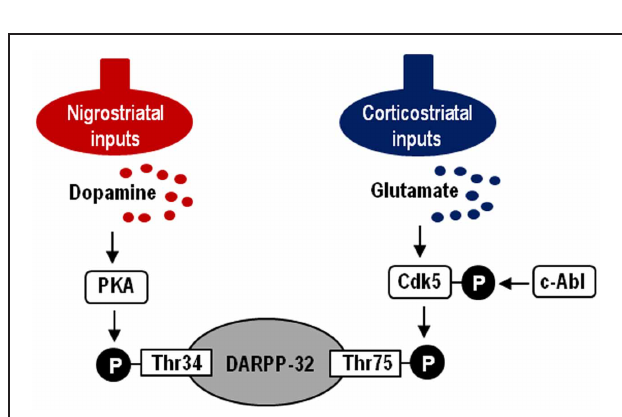
FIGURE 7 | Hypothesized model of striatal Cdk5/DARPP-32 signal regulations. Depicted are postsynaptic dopamine/PKA/Thr34-DARPP-32 and glutamate/Cdk5/Thr75-DARPP-32 signaling cascades. c-Abl is the known kinase to phosphorylate Cdk5 at Tyr15.